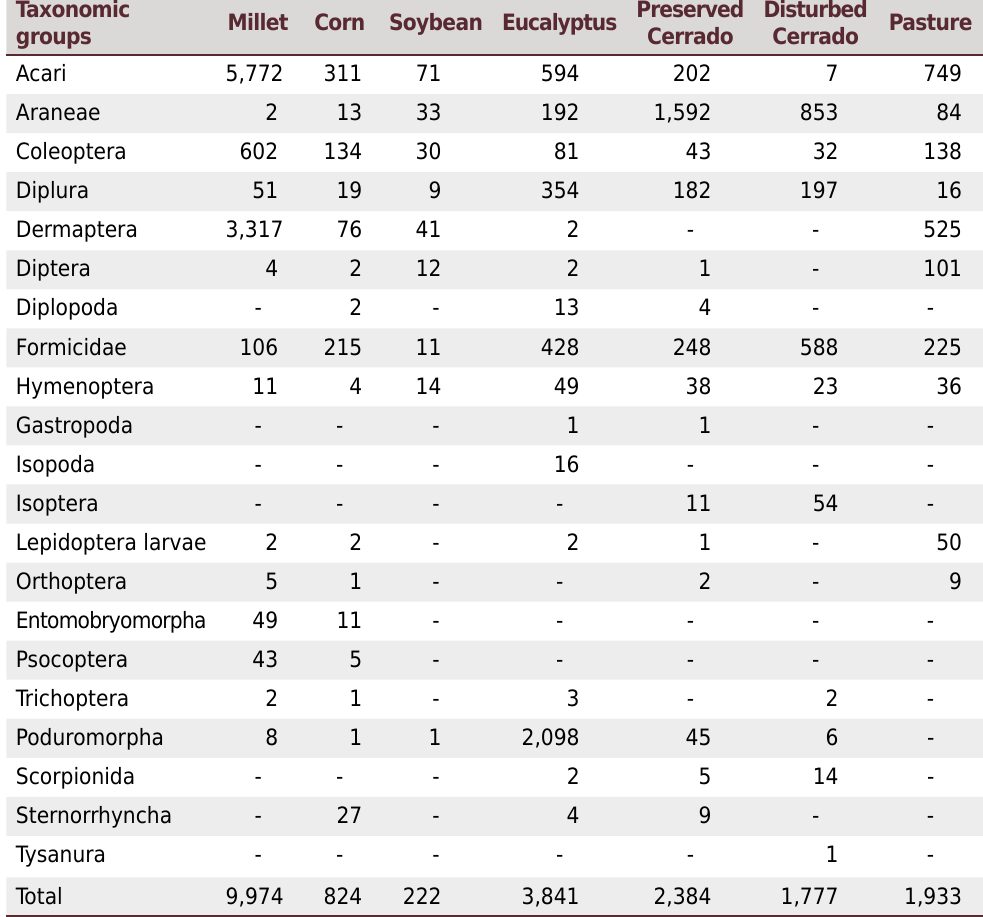
Table 2. Composition of the soil fauna under different use and management in the Cerrado Biome